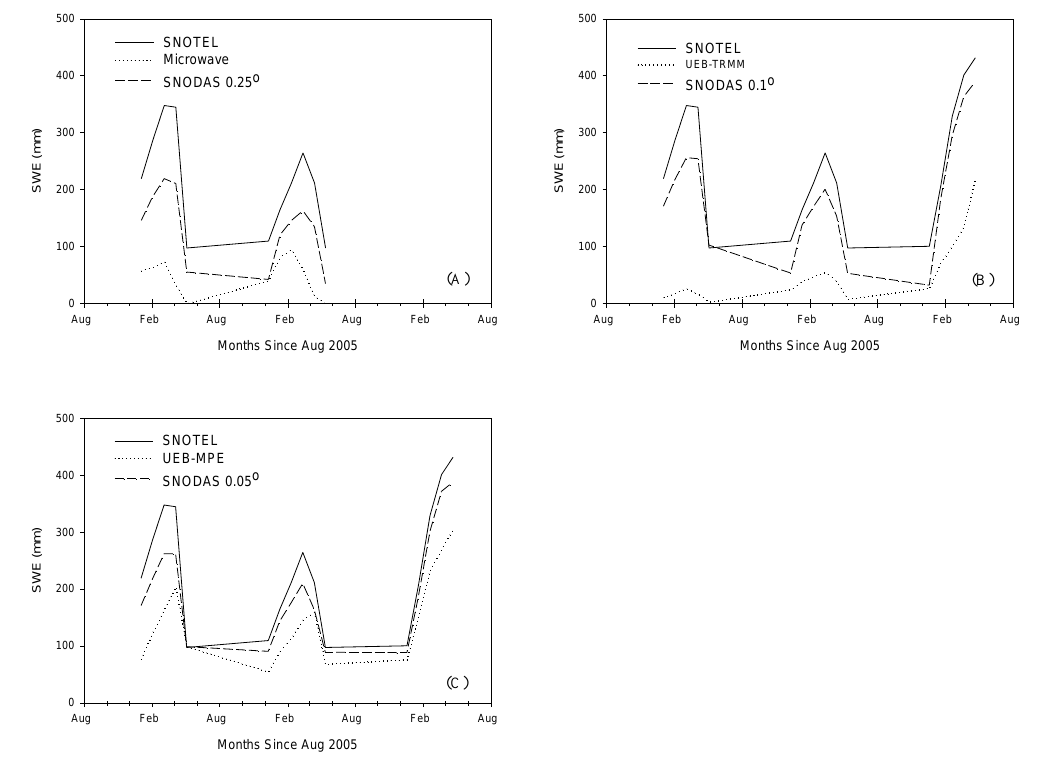
Fig. 9. Time series plots of averaged SWE (at the 39 SNOTEL sites) from SNOTEL and SNODAS and (A) the microwave imagers, (B) sim- ulated with the UEB model with TRMM precipitation, and (C) modeled with UEB model and MPE precipitation.